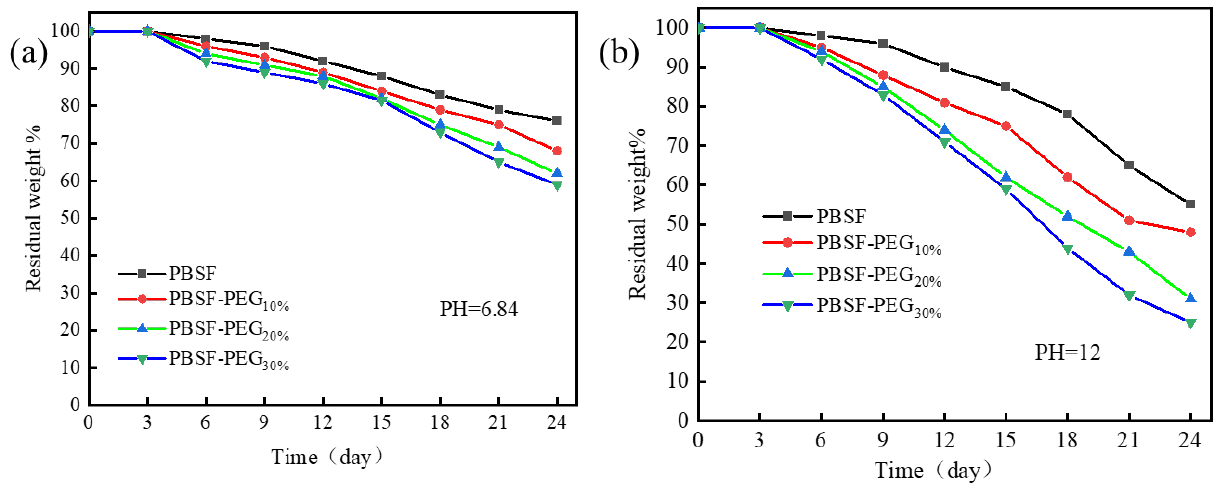
Figure 8. Residual weight as a function of degradation time in ( a ) PBS (pH = 6.84) and ( b ) NaOH solution (pH = 12) at 37 °C for PBSF-PEG.